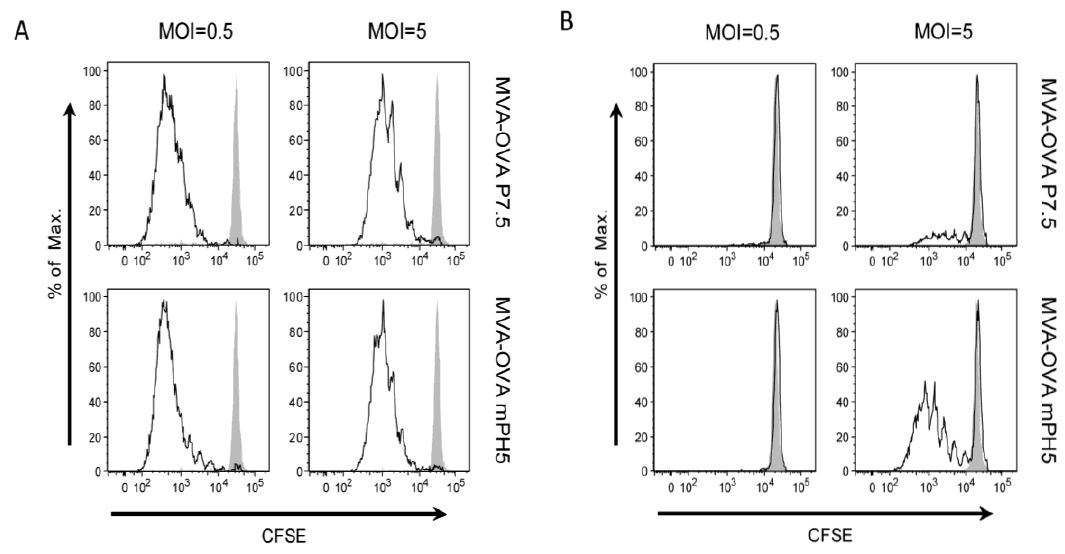
Figure 4. In vitro Ag presentation by DCs infected with MVA-OVA. DCs were infected for 6 h with MVA-OVA P7.5 and MVA-OVA mPH5 at a MOI of 0.5 or 5. Then, DCs were co-cultured with either CFSE-labeled CD8 + T cells from naïve OT-I mice ( A ) or CFSE-labeled CD4 + T cells from naïve OT-II mice ( B ) for 5 days. Proliferation was then assessed by flow cytometry (open histograms). Mock infected DCs were used as control (shaded